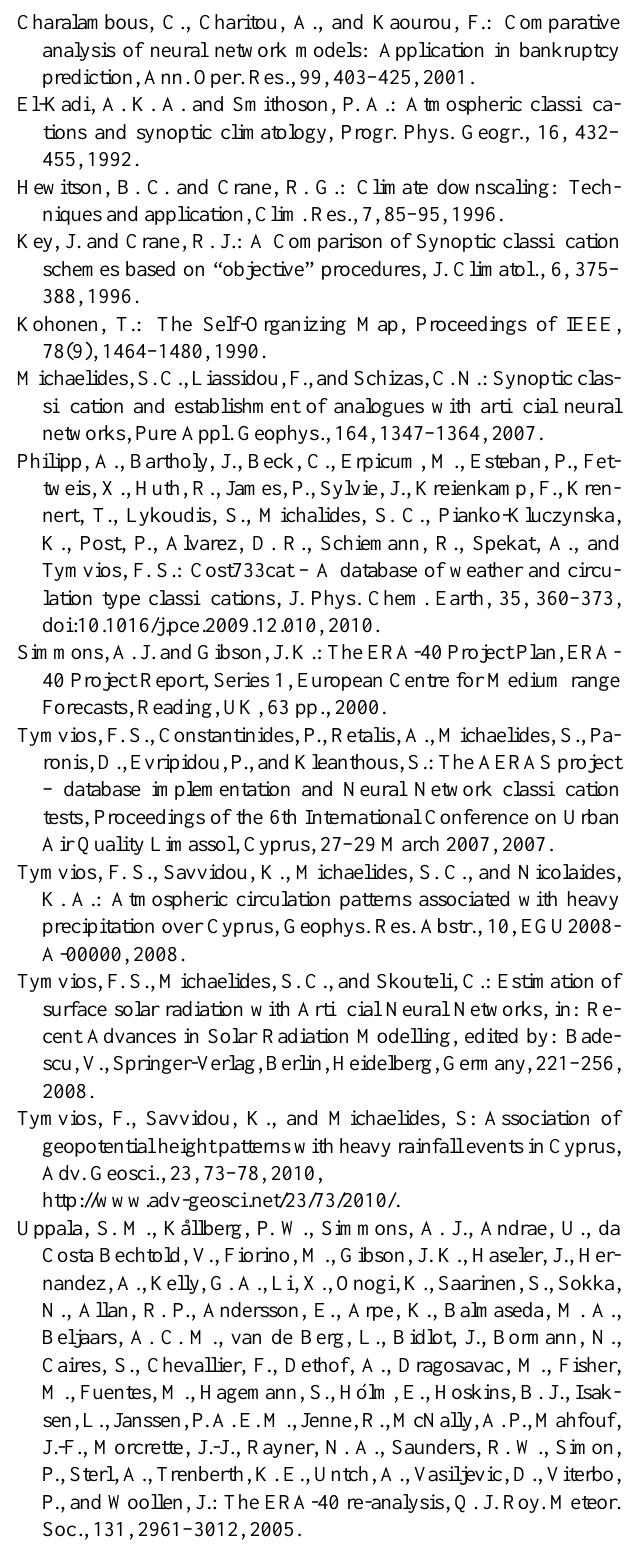
Fig.10. The Ko index for the 36-cluster classification.